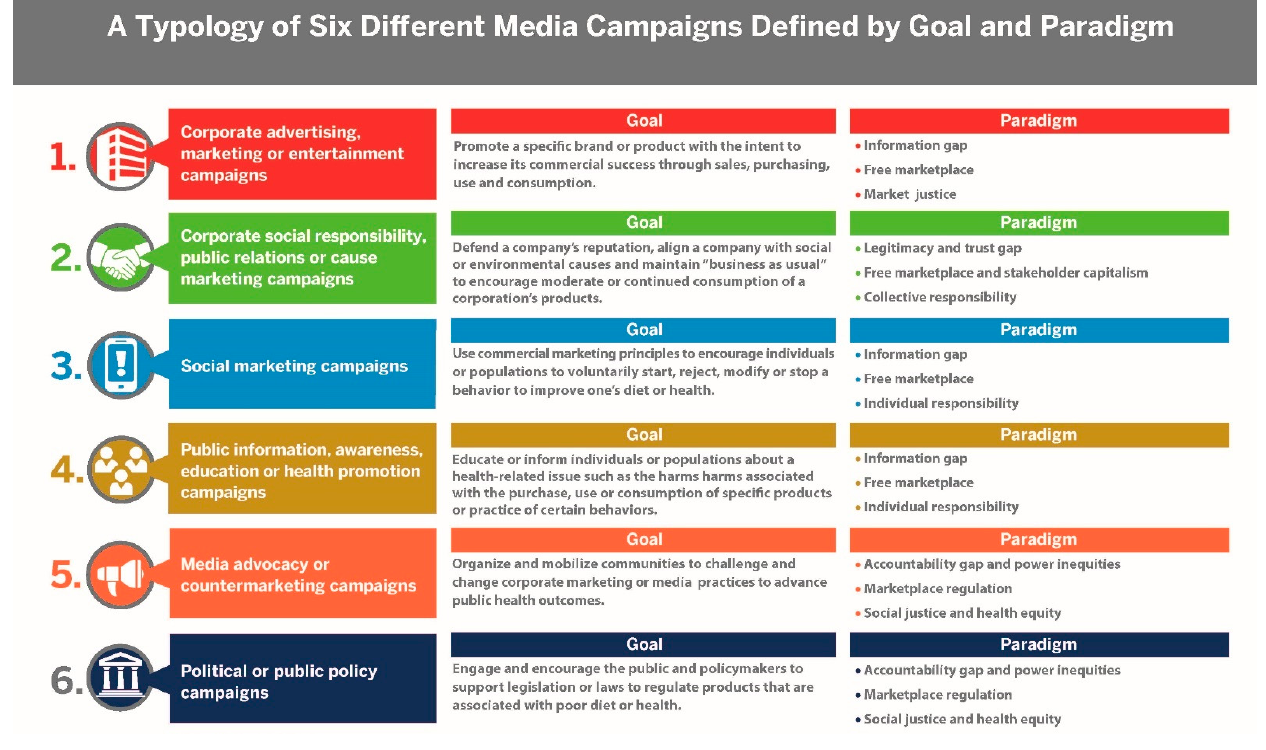
Figure 2. A typology of six different media campaigns defined by the goal and paradigm.